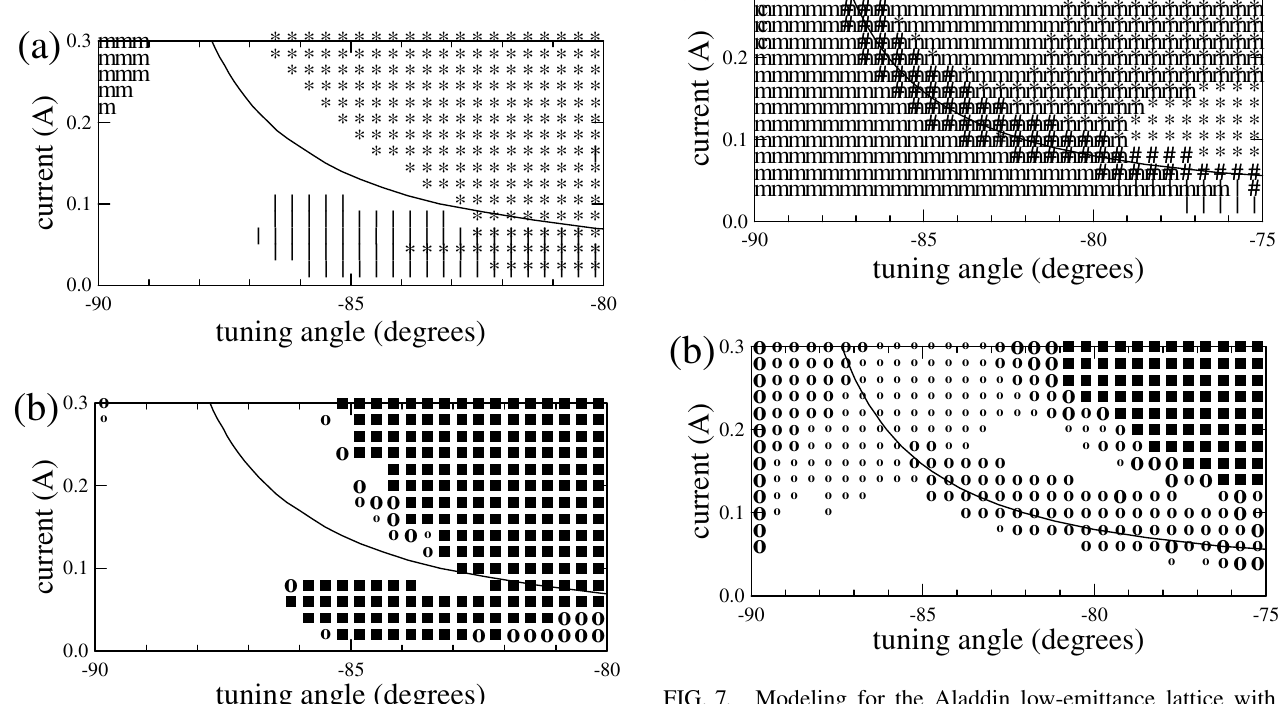
FIG. 7. Modeling for the Aladdin low-emittance lattice with microwave instability from the broadband impedance j Z FIG. 6. Modeling for the Aladdin base lattice with microwave 5 : 7 (cid:3) . A curve shows the parameters for optimal bunch length- =p j (cid:2) 5 : 7 (cid:3) . A instability from the broadband impedance j Z ening. (a) Analytic predictions. m: microwave instability; |: p solid curve shows the parameters for optimal bunch lengthening. coupled-dipole Robinson instability; *: coupled-quadrupole (a) Analytic predictions. m: microwave instability; |: coupled- Robinson instability; #: fast dipole-quadrupole mode-coupling dipole Robinson instability; *: coupled-quadrupole Robinson Robinson instability; c: coupled-bunch instability with longitu- instability. (b) Results of 500 000-turn simulations of 60 000 dinal mode number of 1. (b) Results of 500 000-turn simulations of 60 000 macroparticles. o: mild instability, where the energy spread exceeds its natural value by (10–30)%; o : moderate instability, where the energy spread has increased by (30– 100)%; O : strong instability, where the energy spread has increased more than 100%; (cid:1) : lost